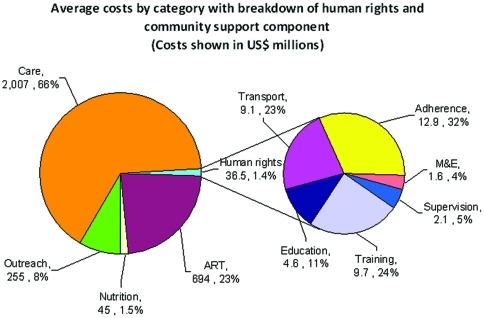
Average annual costs by category with breakdown of human rights and community support components.The pie represents the annual costs based on a CD4<350 scenario without additional prevention averaged over 40 years. Care includes hospital and primary health care (excluding nutrition and human rights), which have their own slices in the pie. Outreach represents the costs of the community-based campaign excluding human rights and community support costs. ART represents ARV costs, aboratory and clinic visits are included in Care category. The other categories are self-explanatory and further details can be found in the Information S1 document.